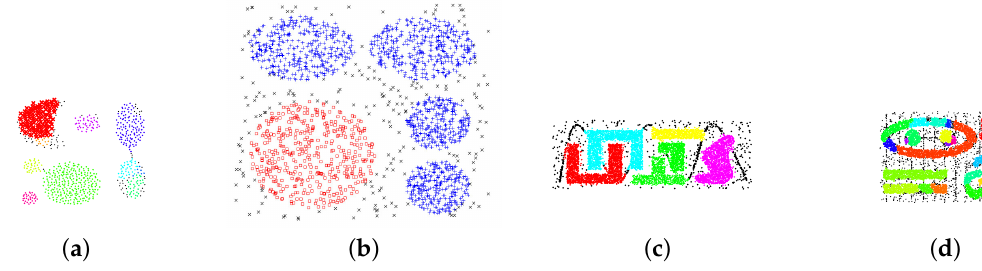
Figure 5. Clustering effect of DBSCAN on four data sets. ( a ) Aggregation. ( b ) DS1. ( c ) t4.8k. ( d )